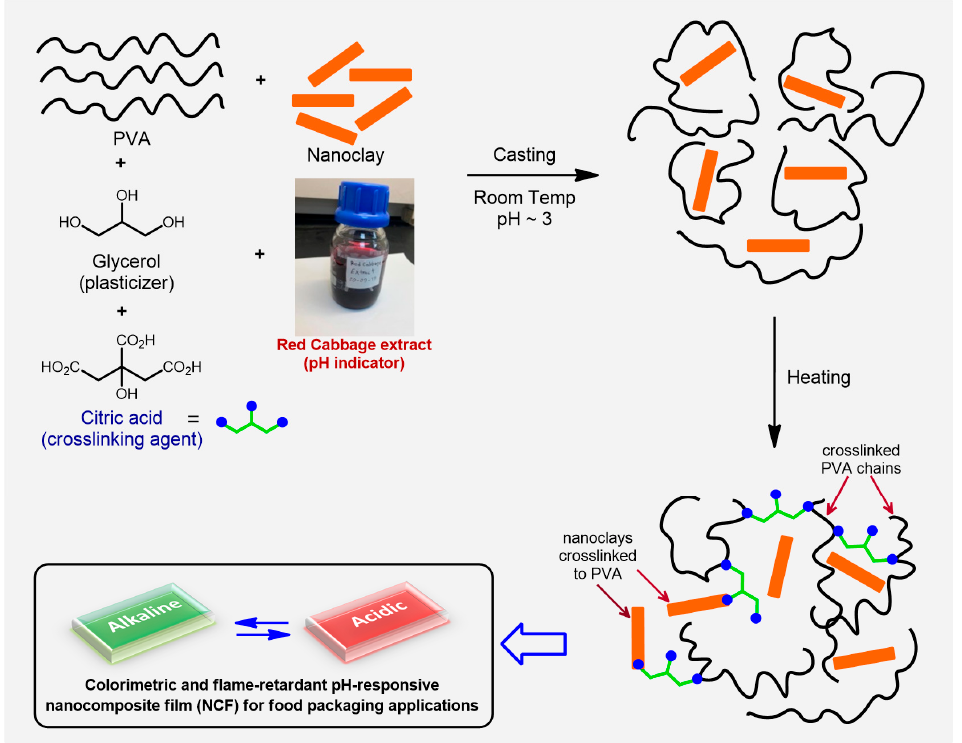
Figure 1. Schematic illustration for the preparation process of the pH-responsive nanocomposite films (NCFs).